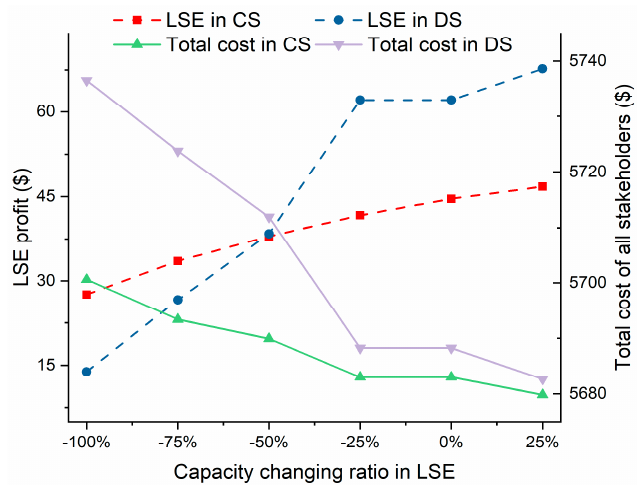
Figure 7. Effect of storage capacity variation on the economic benefit of stakeholders (CS: centralized coordination scheme; DS: decentralized coordination scheme).